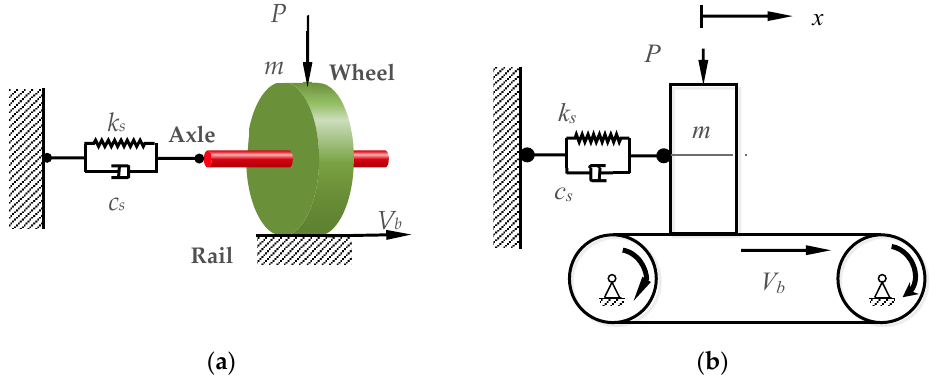
Figure 1. Model of lateral self-excited friction vibration of wheel: ( a ) wheel–rail lateral self-excited vibration model; ( b ) wheel–rail friction self-excited vibration model.